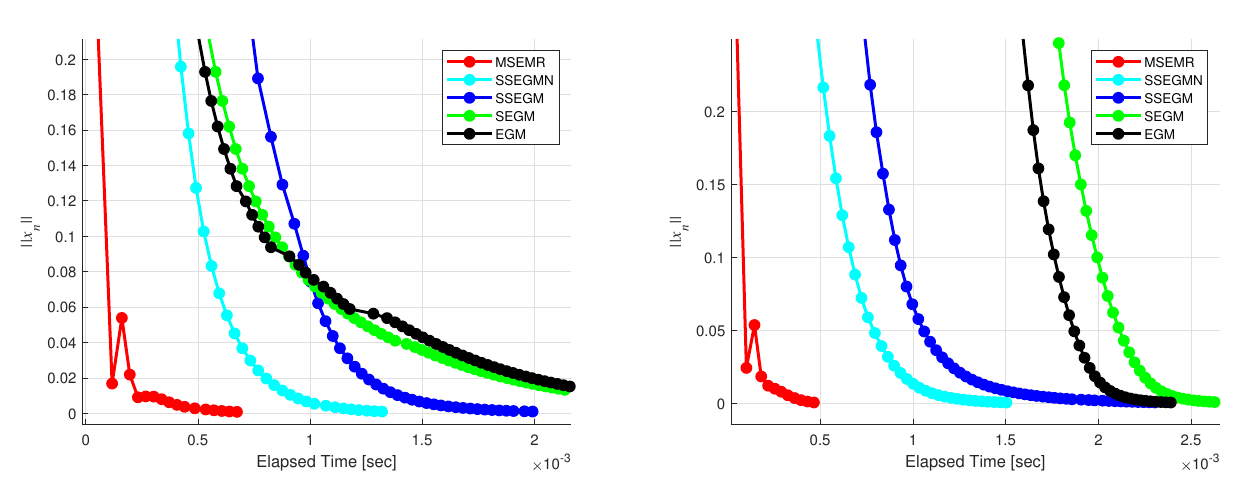
Figure 3. Example 4. Left: m = 5. Right: m =